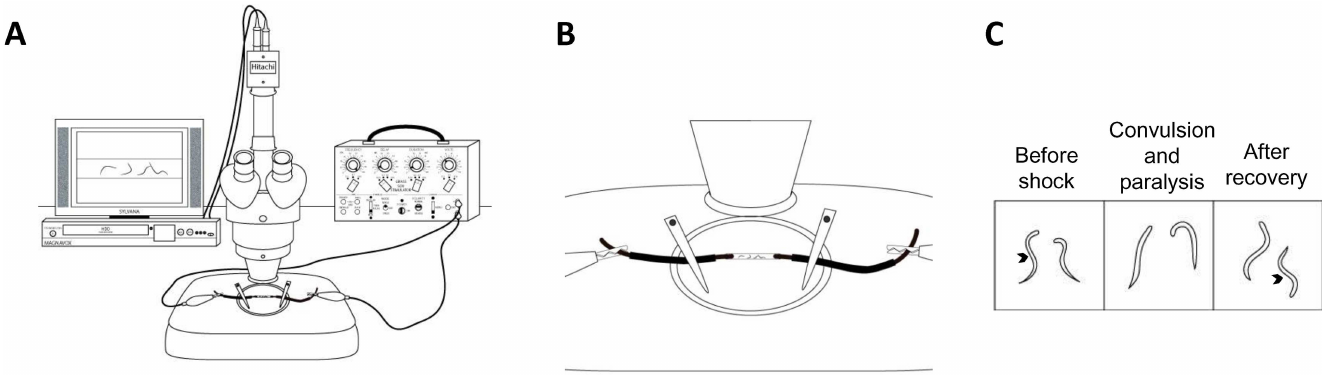
Fig 1. Experimental set up for application of electrical shock in worms. (A) Experimental set up includes a dissecting microscope with an ocular camera. The live image feed is displayed on the TV and recorded with a digital video recorder. (B) A zoomed in view of (A) shows a close up schematic of the experimental tube containing liquid solution and worms with copper wire on either side of tube along with measurements. (C) Schematic of worms before the shock and after recovery are represented with sinusoidal wave body shape (denoted by arrows). During the convulsion and paralysis phase, the worms are generally exhibiting unilateral body bends or